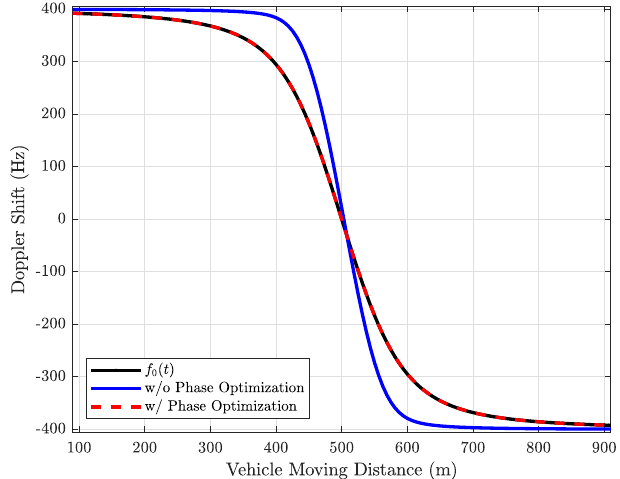
Figure 7. DS for one vehicle pass. D BS is [ 0,20,100 ] T (m), and D MR ( t ) is [ − 500 + vt ,15,20 ] T m.